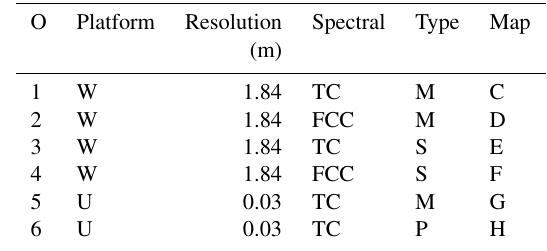
Table 1. Characteristics of the images used to identify and map the Assignano landslide (Fig. 2). O: order in the sequence of images shown to the interpreter. Platform used to capture the image: W, WorldView-2 satellite; U, UAV. Resolution (ground resolution). Spectral (image spectral composite): TCC, true colour compos- ite (red, green, blue); FCC, false-colour composite (near-infrared, red, green). Type (image type): M, monoscopic; S, stereoscopic; P, pseudo-stereoscopic. Map: corresponding landslide map (Fig.